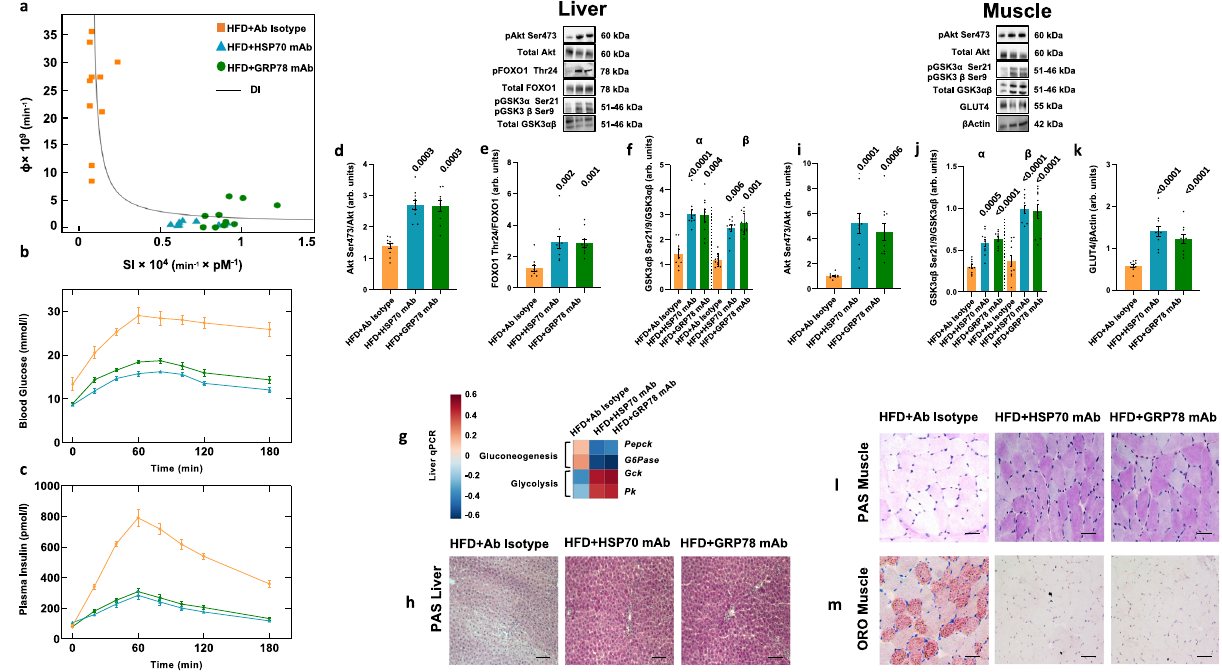
Fig. 4 | Effects of native HSP70/GRP78 inhibition with mAbs on insulin sensi- tivity. a Glucose disposition index (DI) metrics showing experimental data and fi tting curves. Total β -cell responsivity to glucose ( Φ ) is a function of whole-body insulin sensitivity (SI). b , c Time courses of blood glucose and plasma insulin concentrations during anoral glucose tolerancetest. d – f Hepaticphosphorylation of Akt on Ser473 ( d ), FoxO1 on Thr24 ( e ), and GSK3ab on Ser21/9 ( f ). g Gene expression of key enzymes involved in hepatic gluconeogenesis and glycolysis. h RepresentativeimagesshowingperiodicacidSchiff(PAS)stainingofliversection fromratsfedHFDandinfusedwithmonoclonalantibodiesagainstHSP70orGRP78